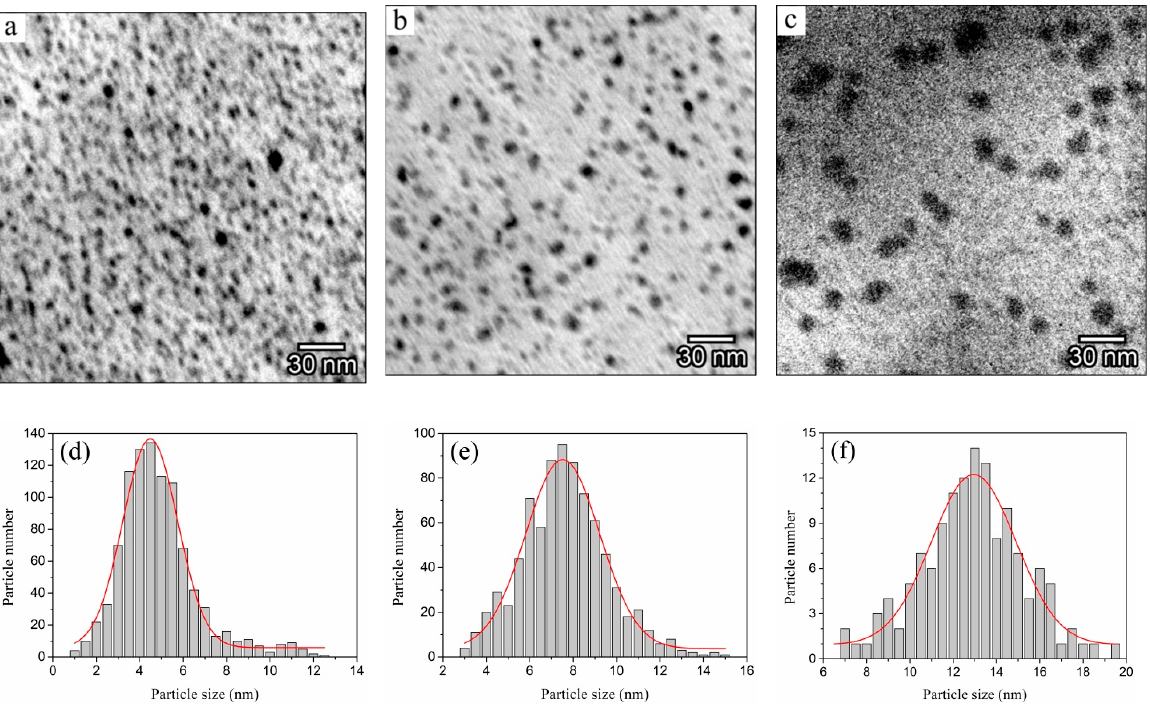
Figure 1. TEM images ( a – c ) and particle distribution in size ( d – f ) of Ag/PAN nanocomposite films, obtained at different concentrations of AgNO 3 , wt.%: 10 ( a , d ), 20 ( b , e ), and 30 ( c , f ).